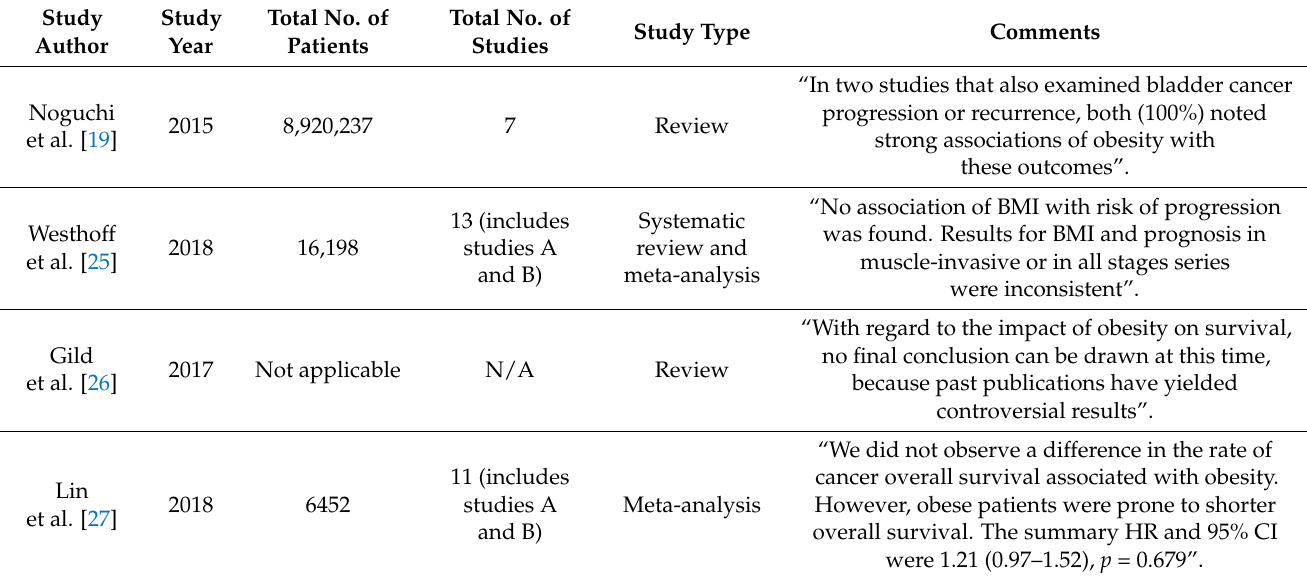
Table 2. Obesity and the prognosis of bladder